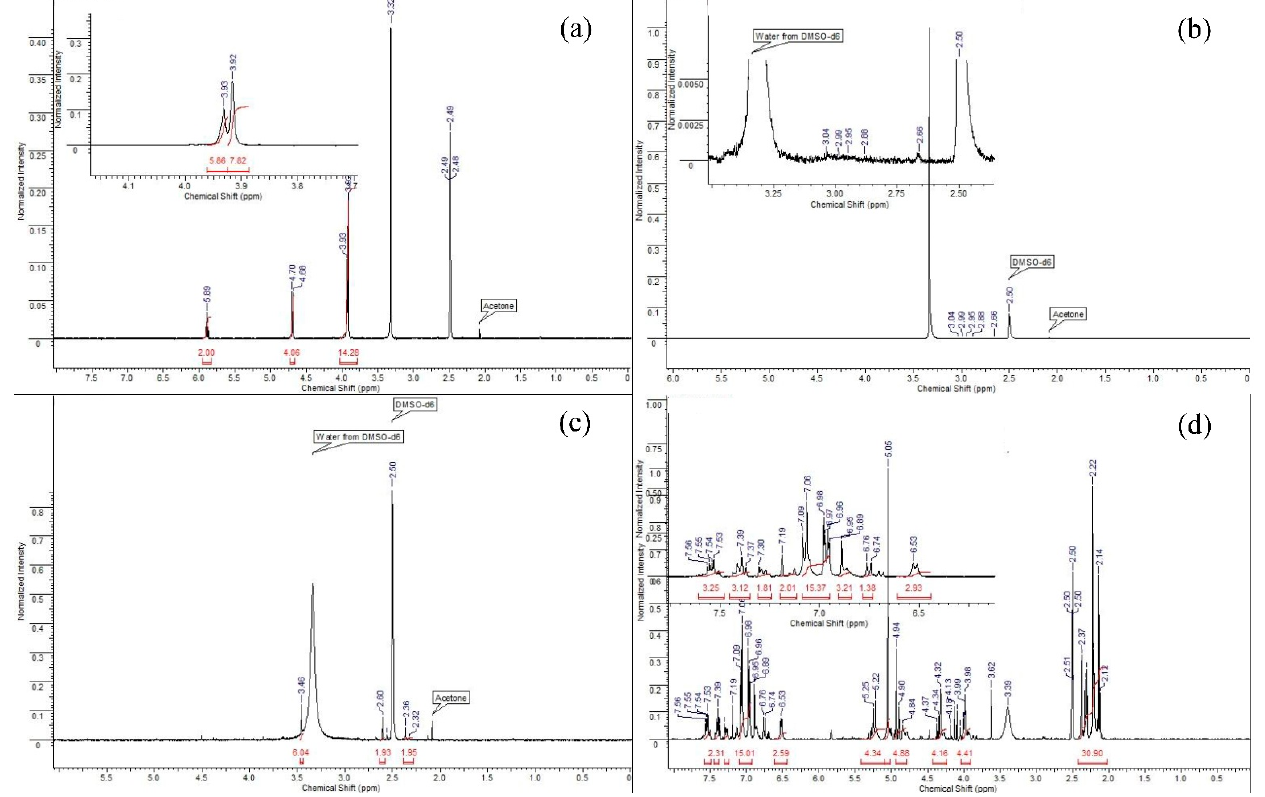
Figure 4. The 1 H NMR spectrum of sorbents (( a ): PTE, ( b ): PED, ( c ): TDA, ( d ): PhED).